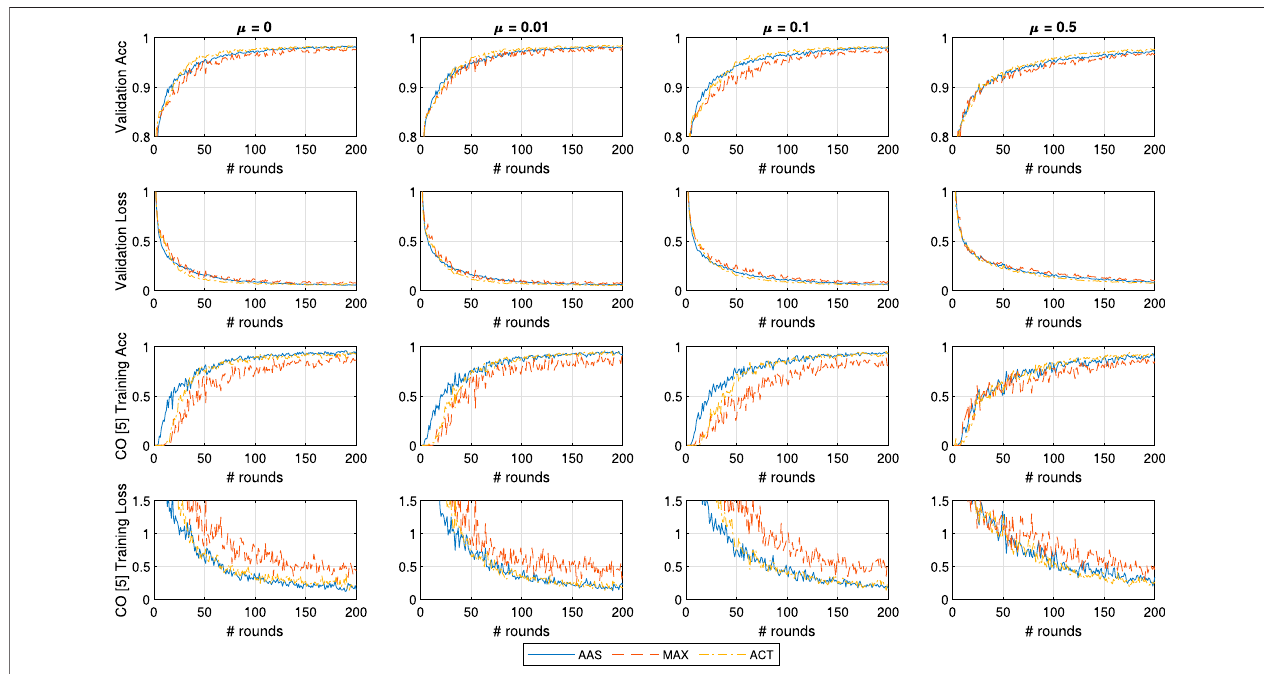
FIGURE 4 | General and CO-speci fi c accuracy and loss results obtained when testing all three methods in combination with FedProx using the MNIST dataset.